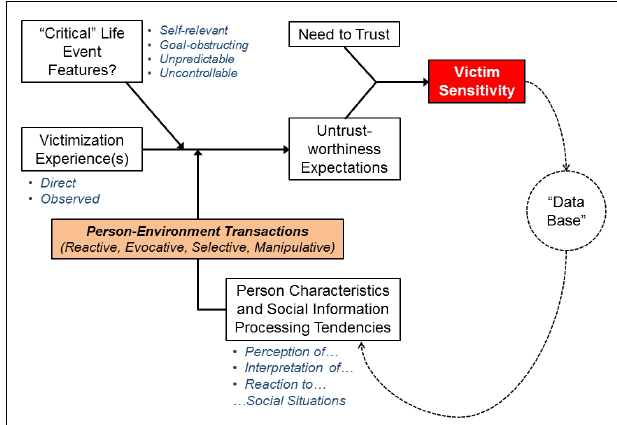
FIGURE 1 | Theoretical model explaining the “ontogenetic” stabilization of victim sensitivity across the